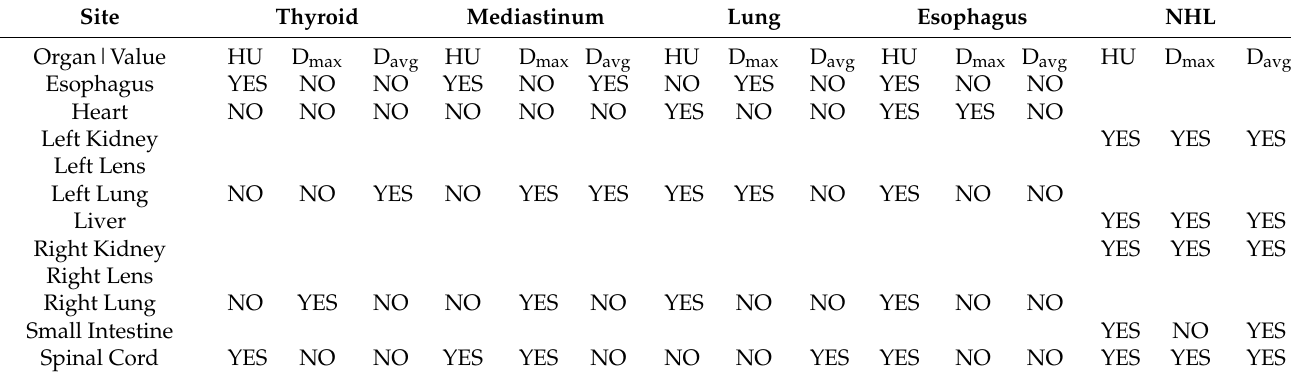
Table 4. Summary of statistical analysis results for critical structures in chest. “YES” indicates statistically significant difference in CT number (HU), maximum dose (D max ), and mean dose (D avg ) values between NCCT and CCT images, and “NO” is vice versa.